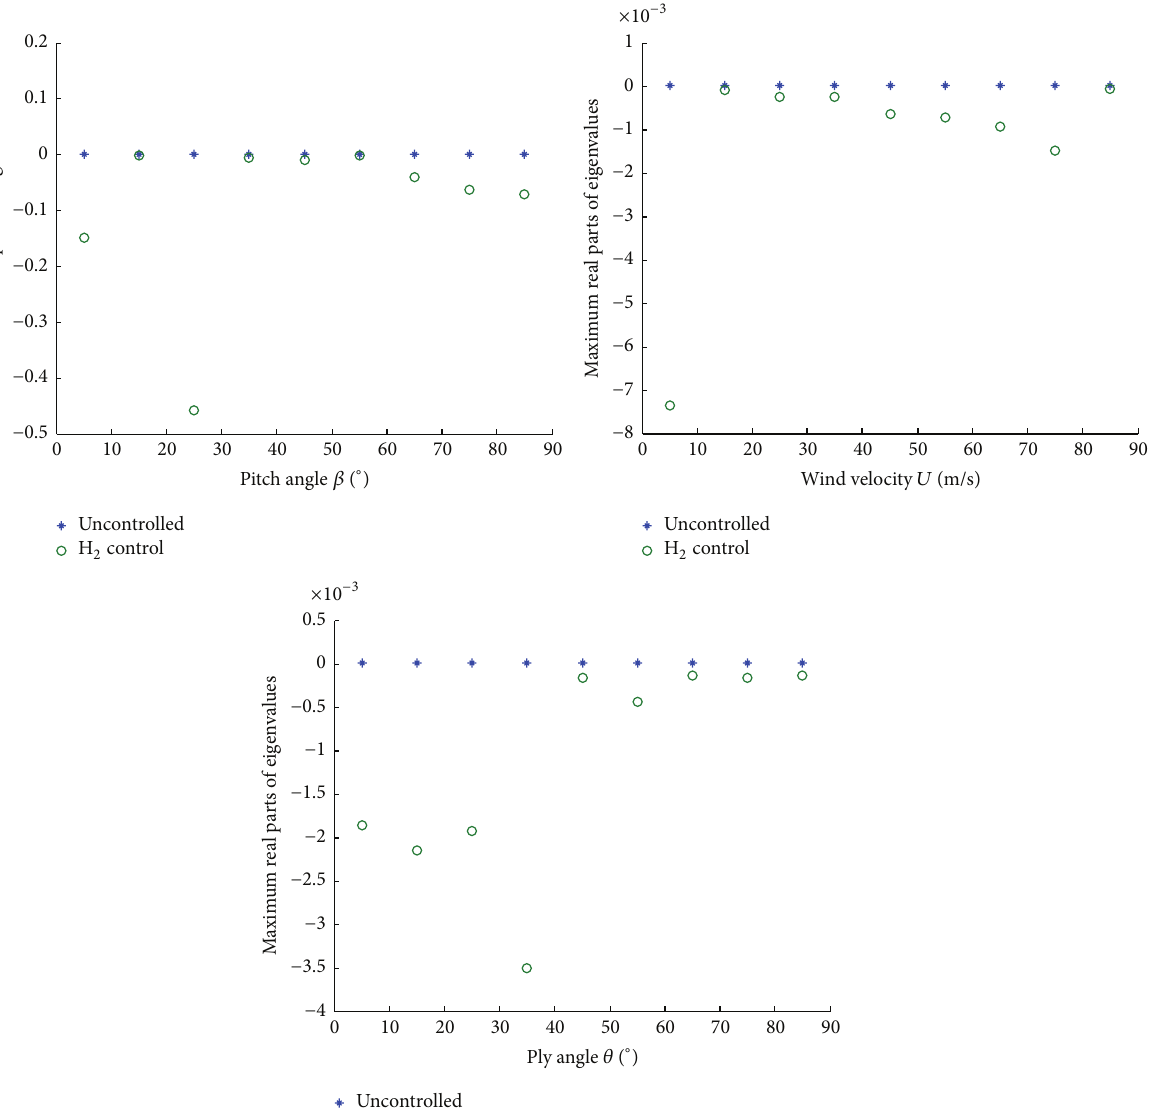
which is between − 80 m and 80 m, far beyond the length of the blade, in fact, is an unstable